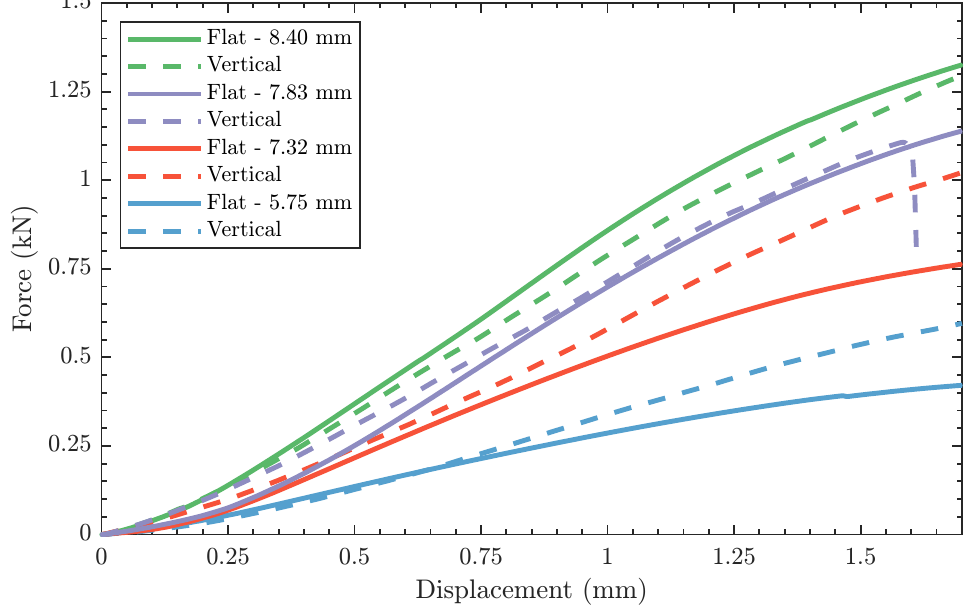
Figure 5. Average force-displacement curves of flat-printed and vertically-printed